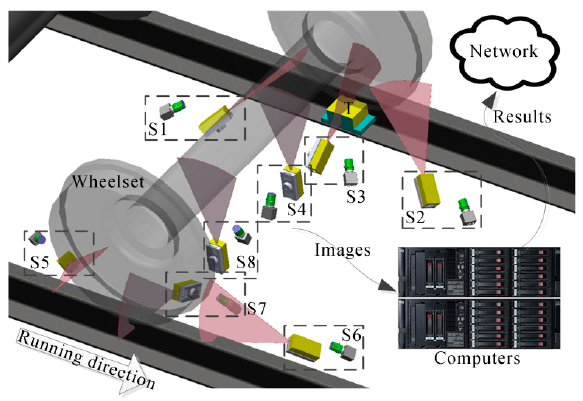
Figure 1. Measurement system structure. S1 – S8: Structured-light sensors; T: electromagnetic sensor.